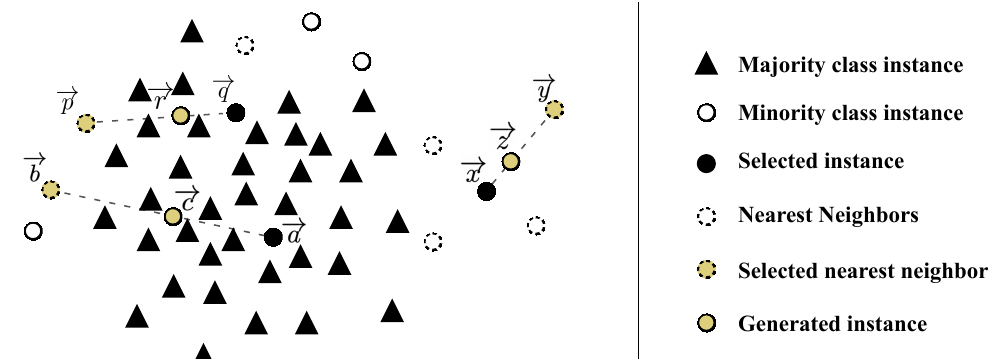
−→ x and −→ −→ −→ y to produce z . Noisy instance r was generated by −→ −→ q and randomly selecting its nearest neighbor p from a different minority class −→ −→ c was generated by randomly selecting the noisy minority class instance a −→ b